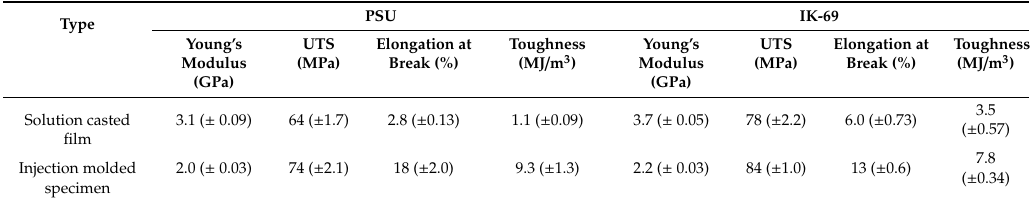
Figure 5. Tensile stress–strain curves of PSU and IK-69 (( a ) solution cast films, ( b ) melt injection molded specimens). Table 4. Tensile properties of PSU and IK-69.